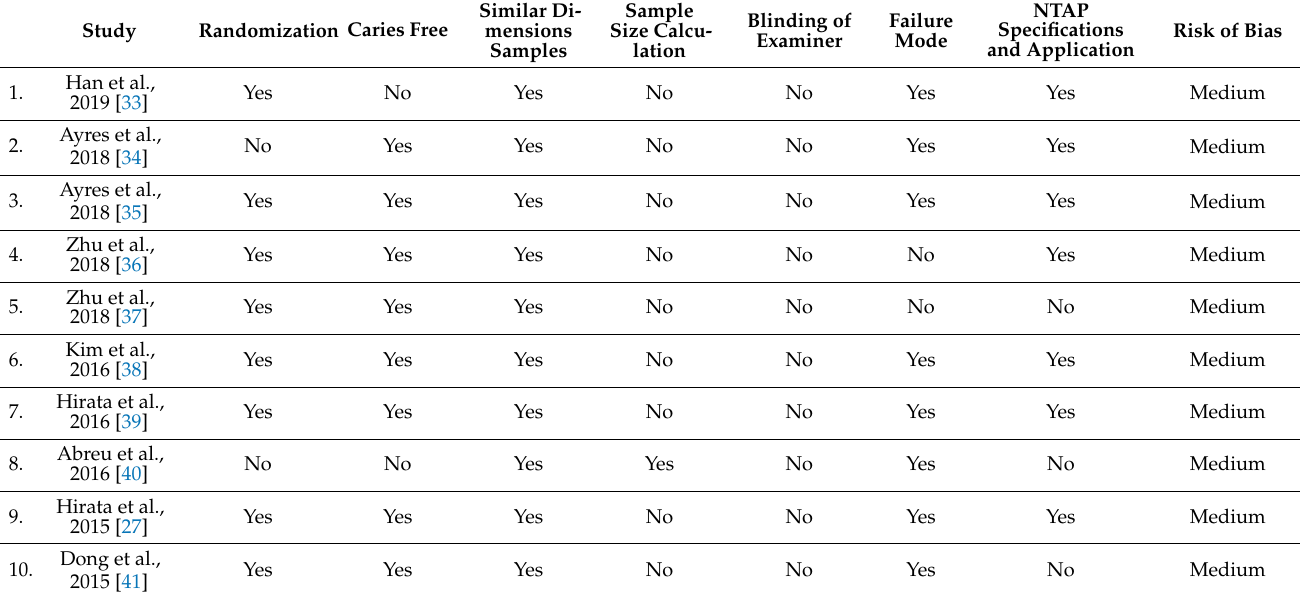
Table 3. Assessment of risk of bias for the included